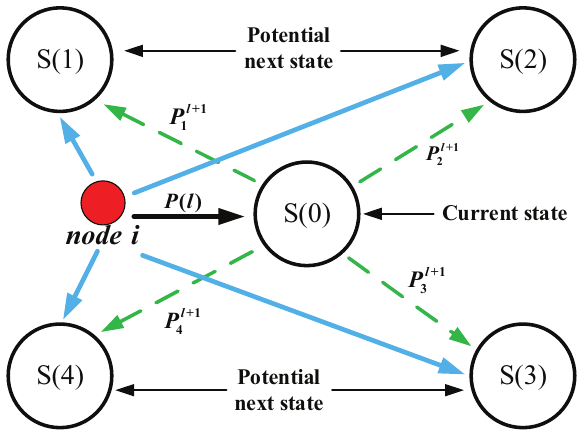
Figure 2. The Markov state prediction model for the mobile trajectory of nodes in the